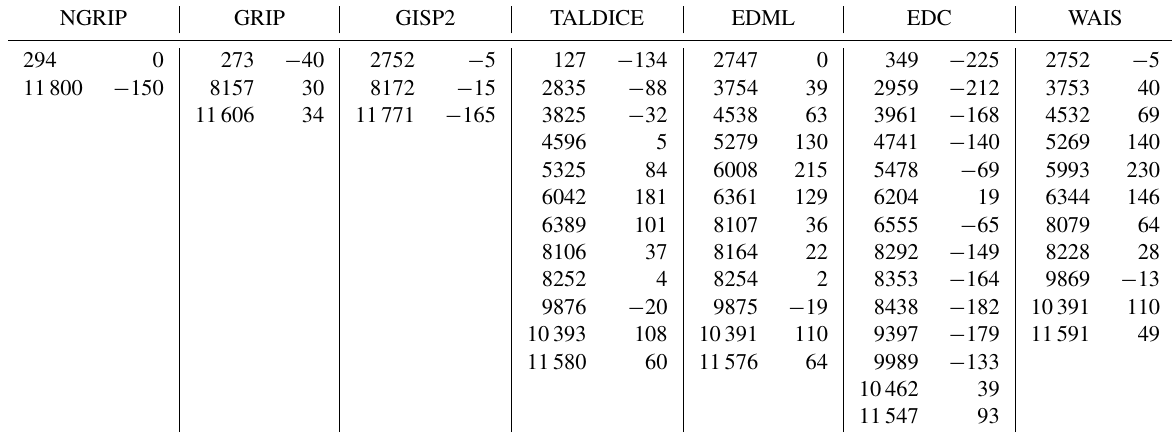
Table 3. Time synchronisation. Tie points of the reference timescale for the individual ice cores (left column, in yrBP) and time corrections (right column, in years) applied with respect to the core-dependent timescale listed in Table 2. The correction values are linearly interpolated among the tie points and held constant before the earliest and after the latest tie